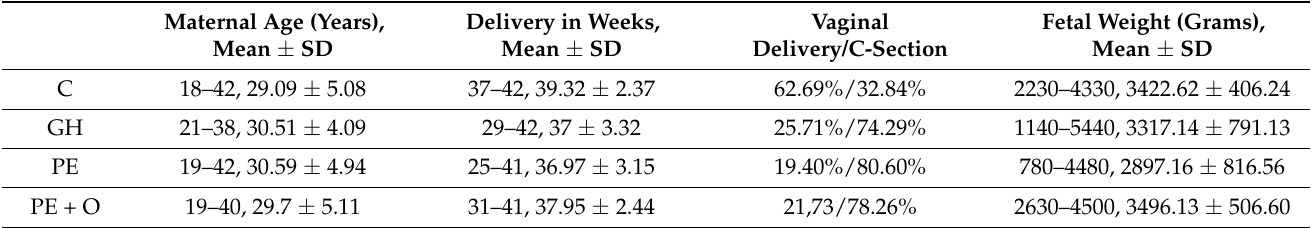
Table 2. Baseline